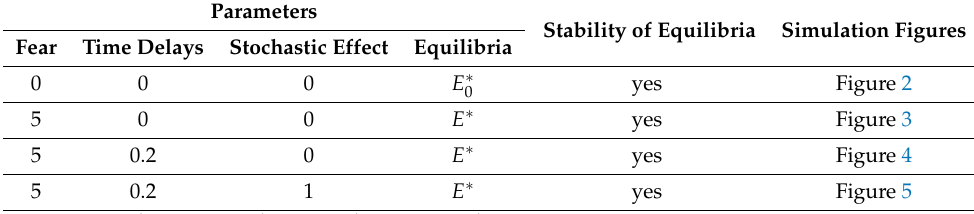
Table 2. Numerical simulations of (4) with parameters given in (9). Parameters Stability of Equilibria Simulation Figures Fear Time Delays Stochastic Effect